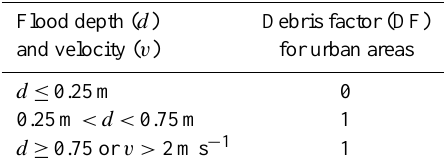
Table 4. Classification of water depth from flood hazard maps pro- vided by the GIS Centre of the Canton of Zurich.